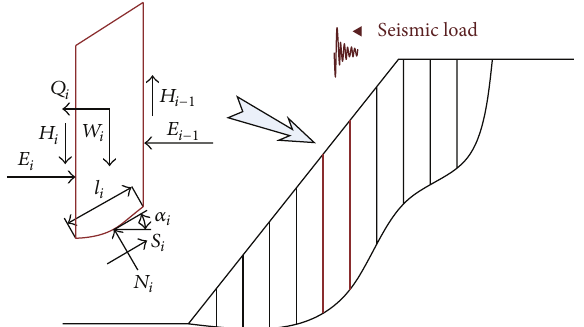
Figure 3: Force diagram on noncircular slip surface with slices based on Janbu